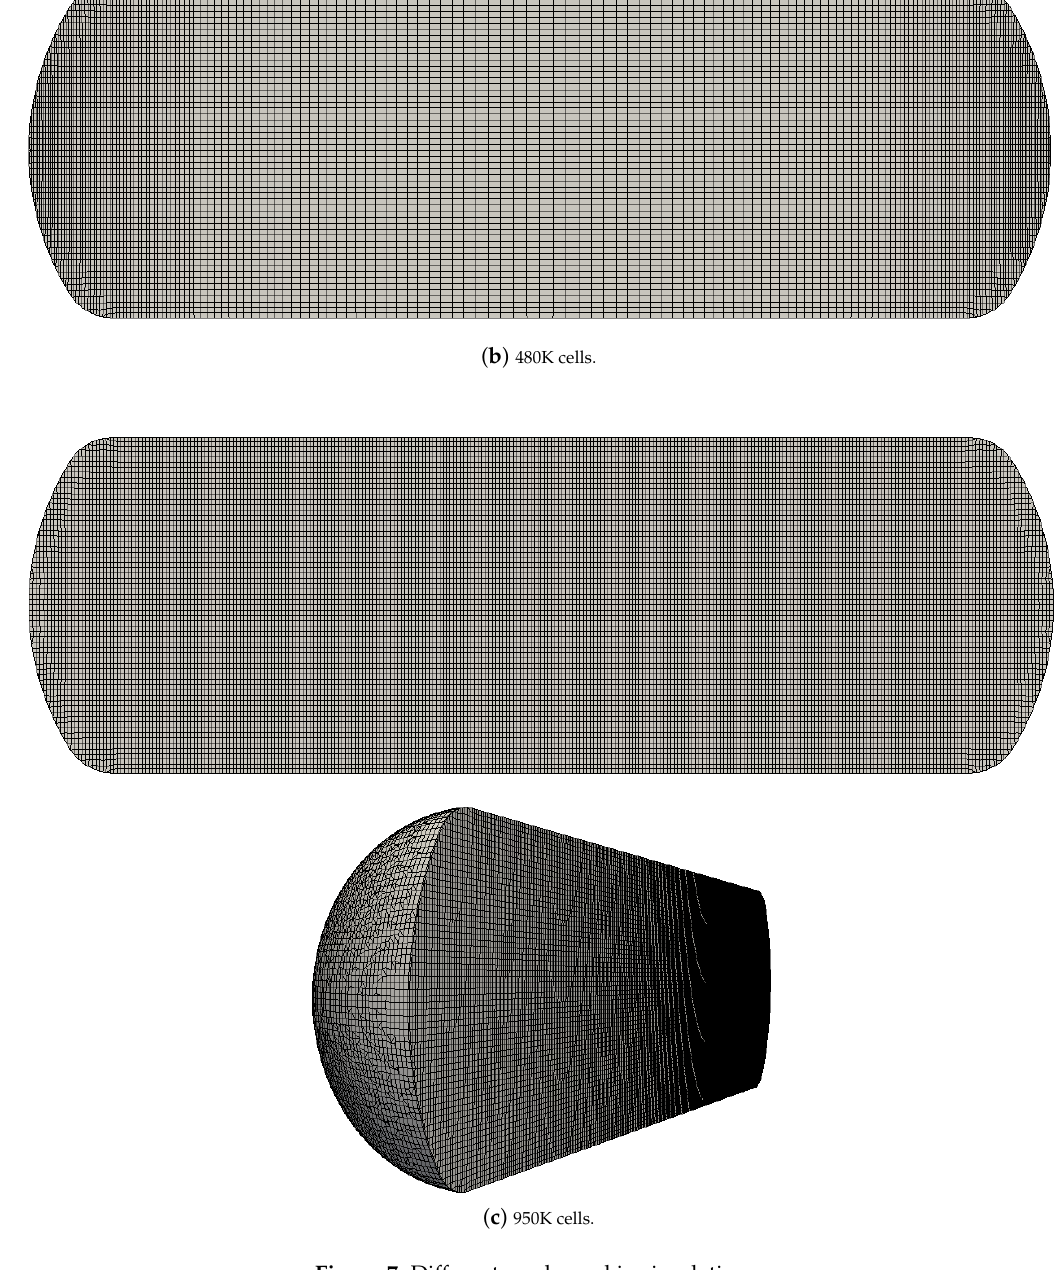
Figure 7. Different mesh used in